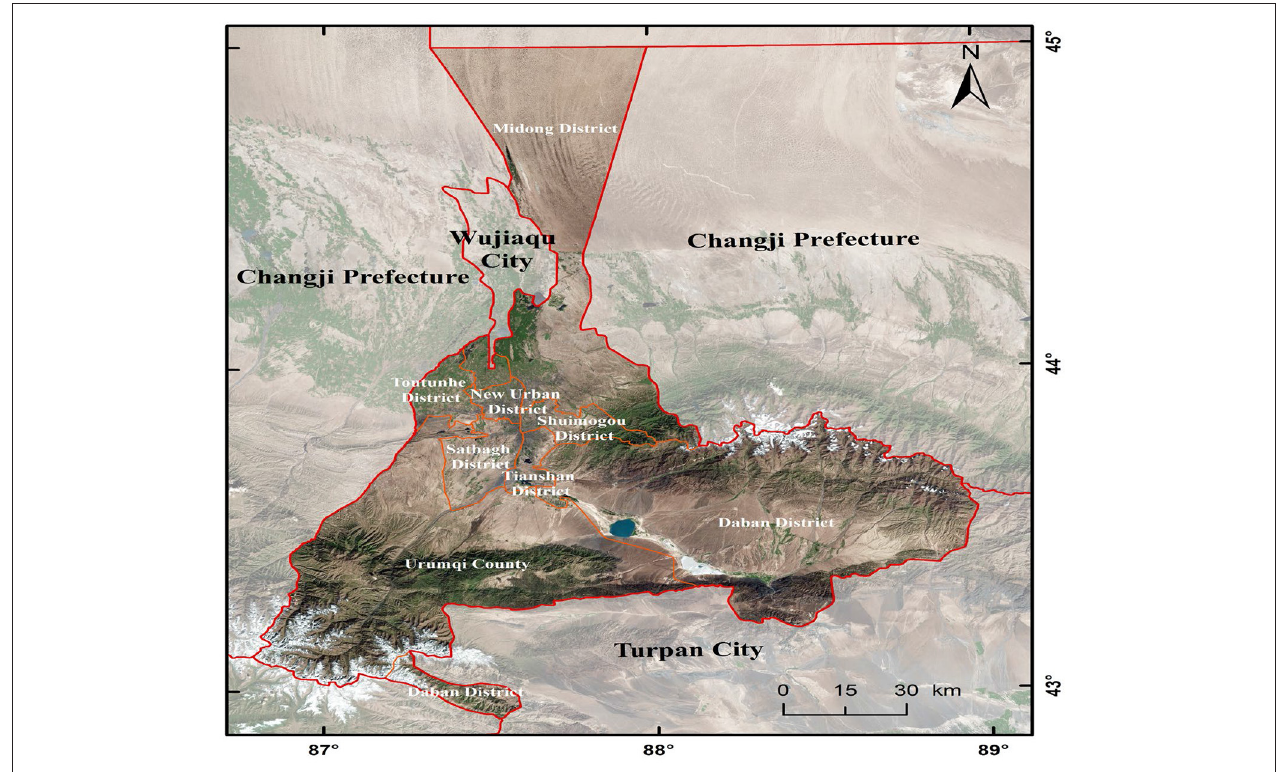
FIGURE 1 | Geographical location of Urumqi City, China.